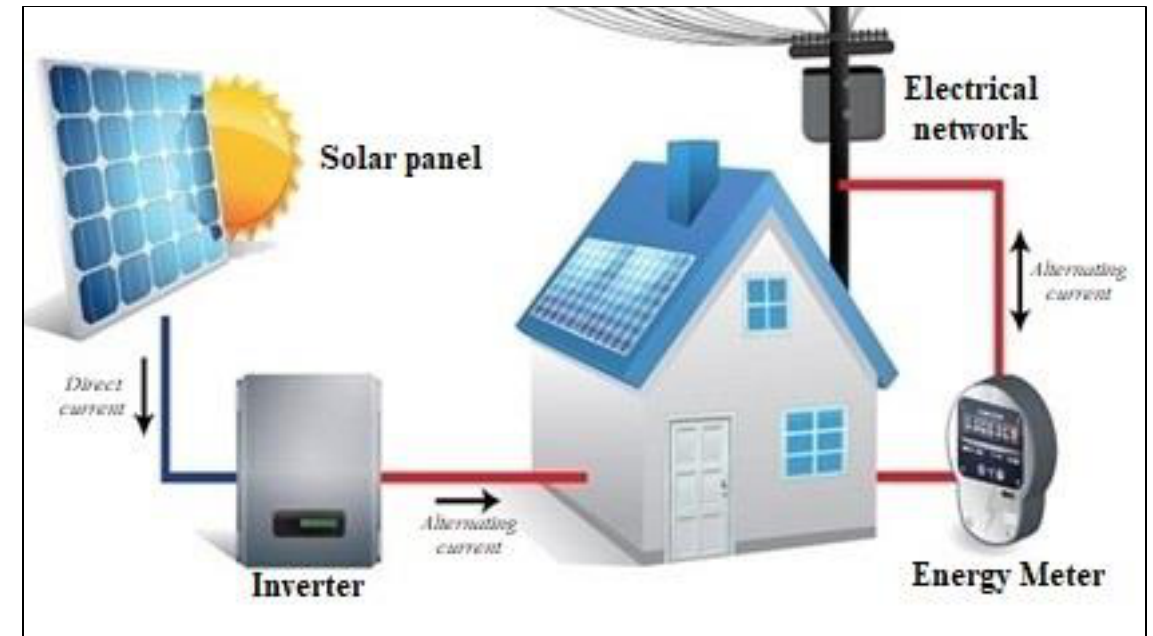
Figure 4: Composition of the photovoltaic solar system connected to the grid. Source: CSR ENERGIA SOLAR, (2008)